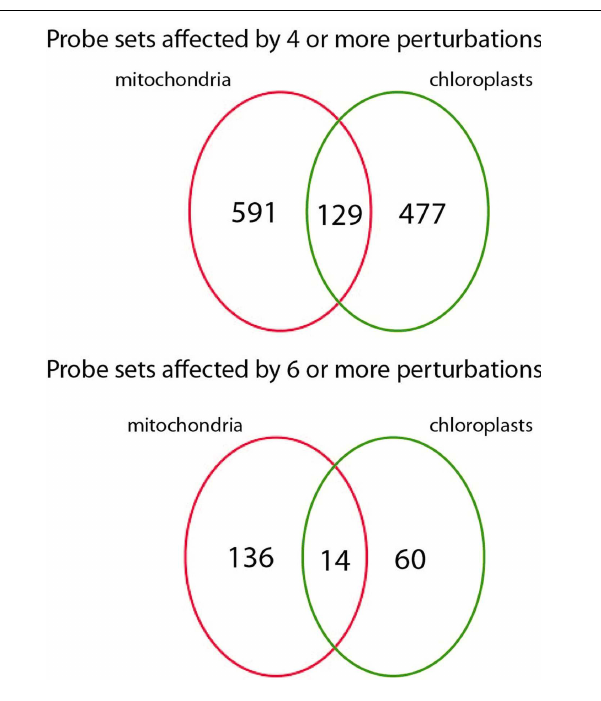
FIGURE 1 | NumberATH1 microarray probe sets responding to mitochondrial and chloroplast perturbations. Number of probe sets that were significantly altered in at least four (top) or six (bottom) microarray experiments relating to mitochondrial or chloroplast perturbations and their